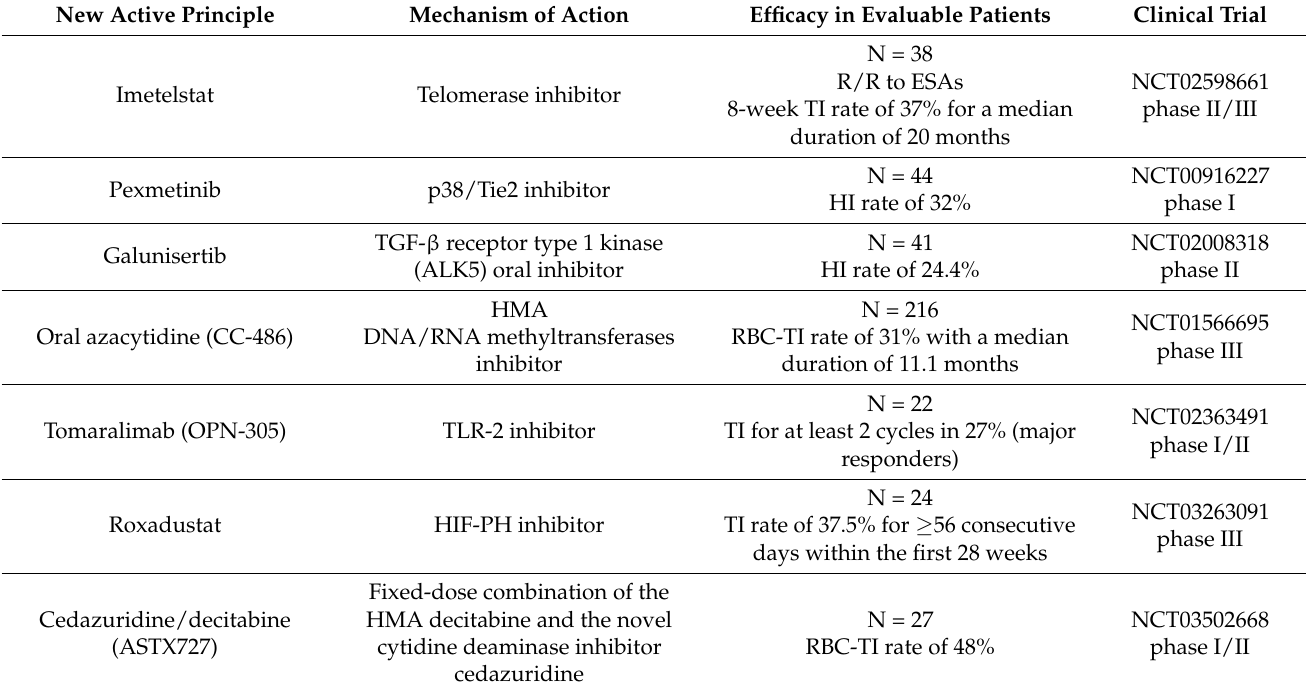
Table 1. New drugs for lower risk